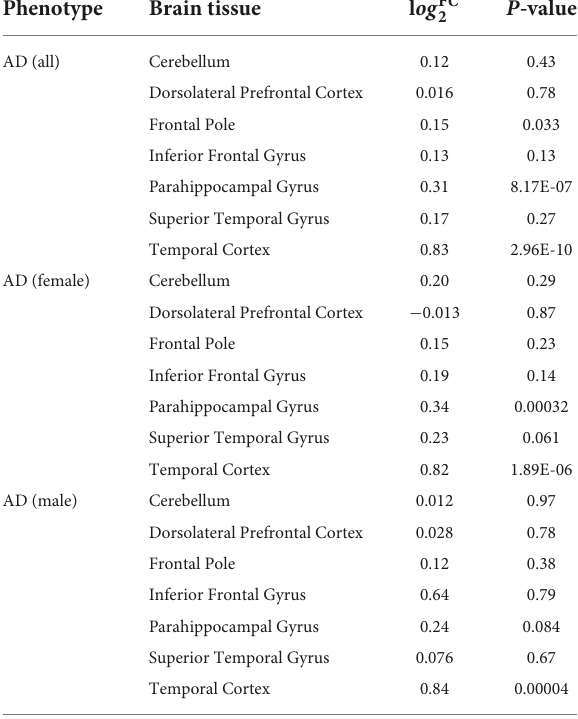
TABLE 3 Differential mRNA expression of CLU in AD and normal samples.